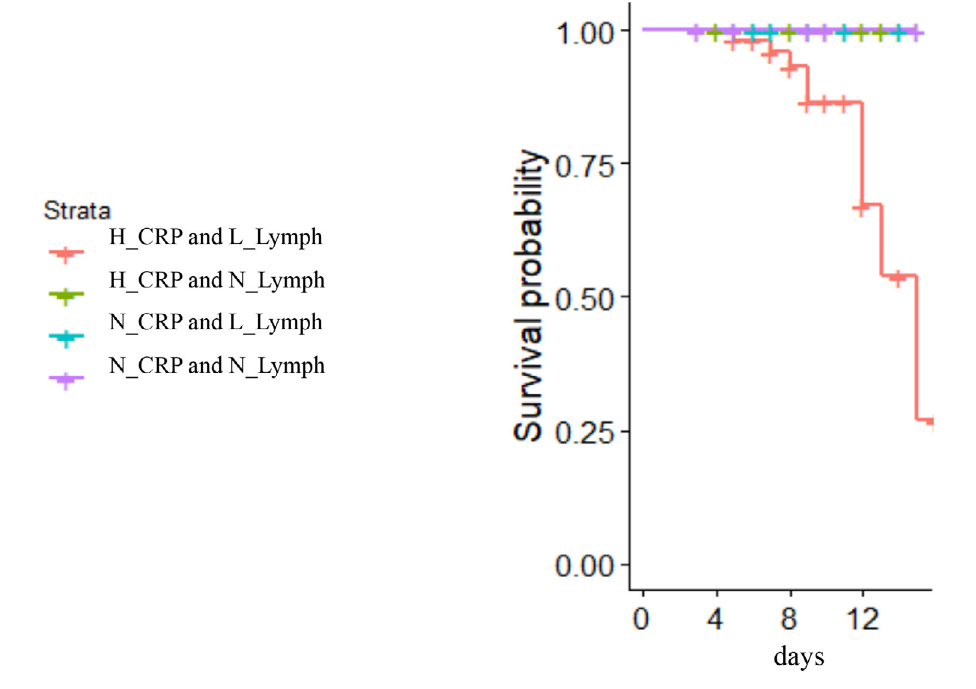
Figure 4. Mortality after TCZ is seen only in persons with highest CRP levels and low lymphocyte counts at treatment